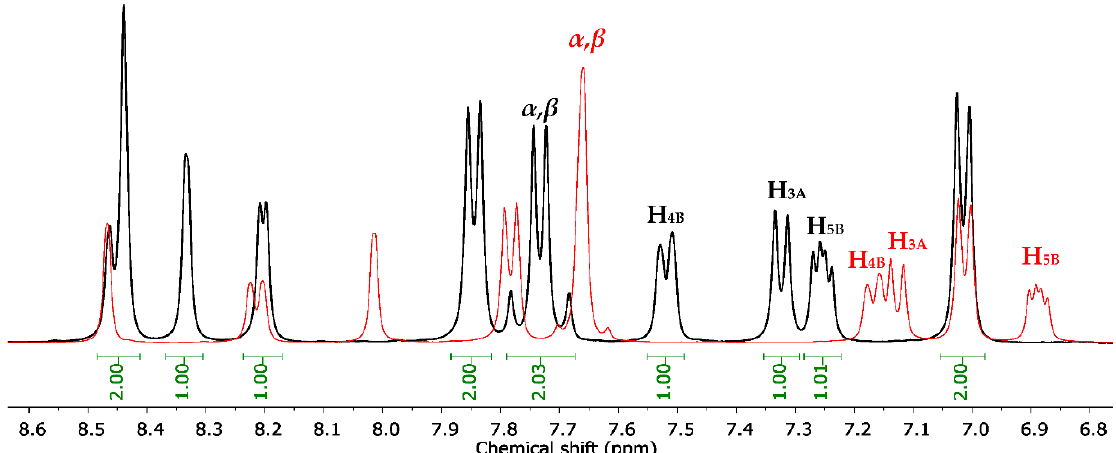
Figure 3. 1 H NMR spectrum (400 MHz, DMSO- d 6 ) of compound 16d : ( a ) salt form (basic media) and ( b ) neutral.